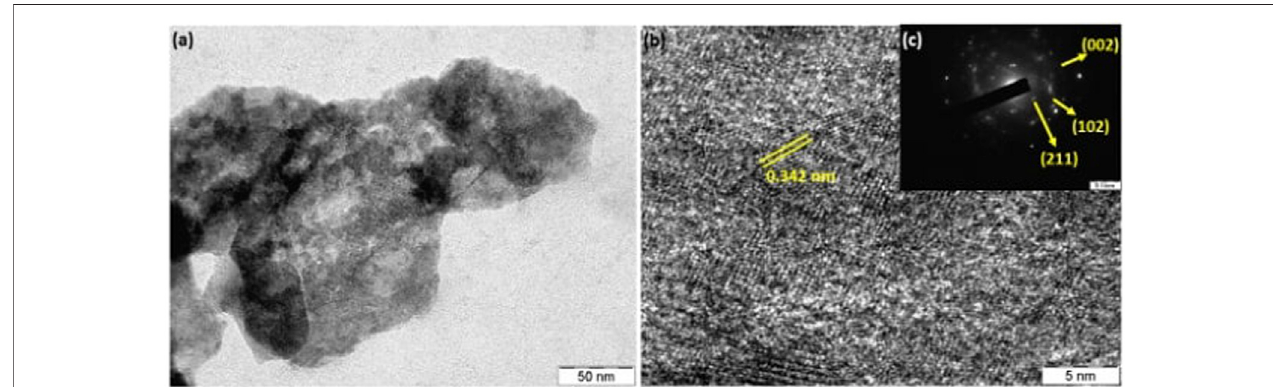
Frontiers in Chemistry |